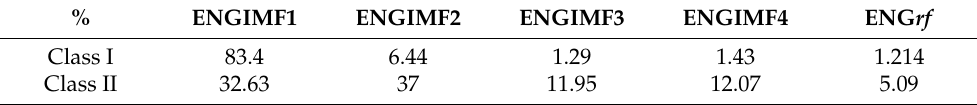
Table 3. Average energy ratios of class I/II with IMF1/2/3/4/ RF . %